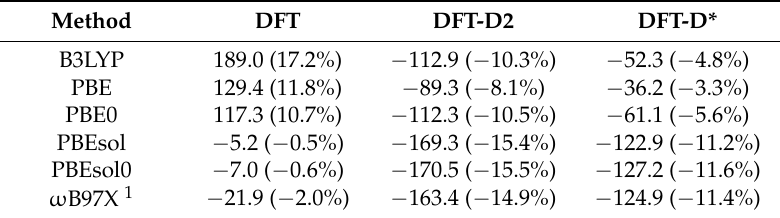
Table 1. Differences of unit cell volume [ ∆ V = V(E) − V(XRD), in Å 3 , and ∆ V/V = ∆ V/V(XRD), in %] as calculated with different XCFs and models for PYV3. The 6-31G(d,p) basis set was used for all